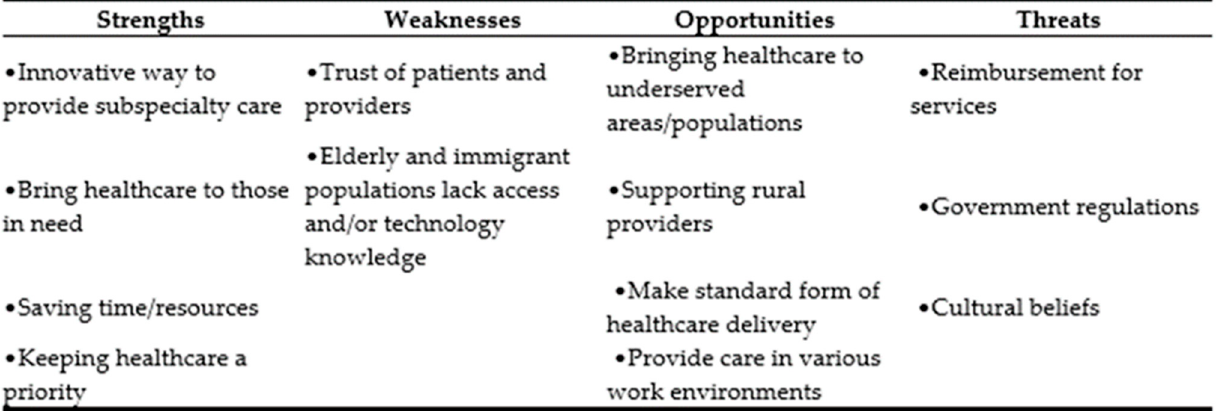
Figure 2. Strengths, Weaknesses, Opportunities, Threats (SWOT)